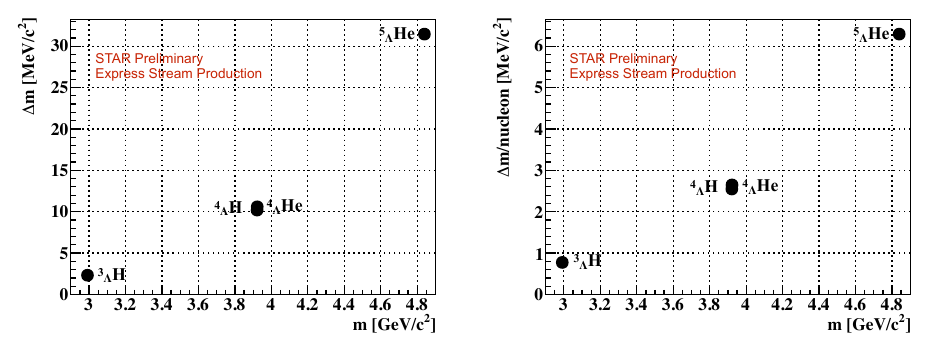
Figure 6. The binding energy of the hypernuclei increases for heavier hypernuclei up to 5 Λ He. Only statistical errors are shown, which are smaller than the symbol